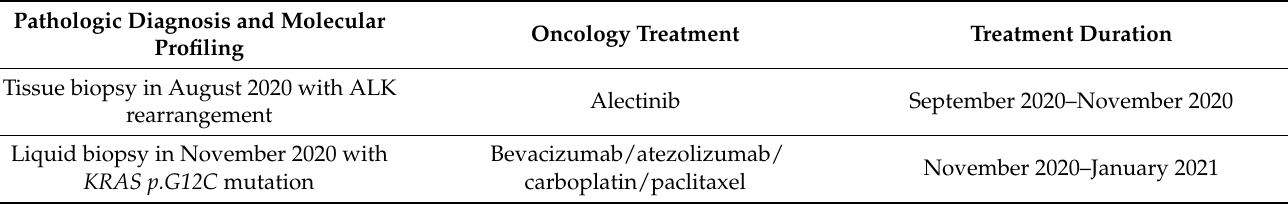
Table 1. Oncology history and treatment